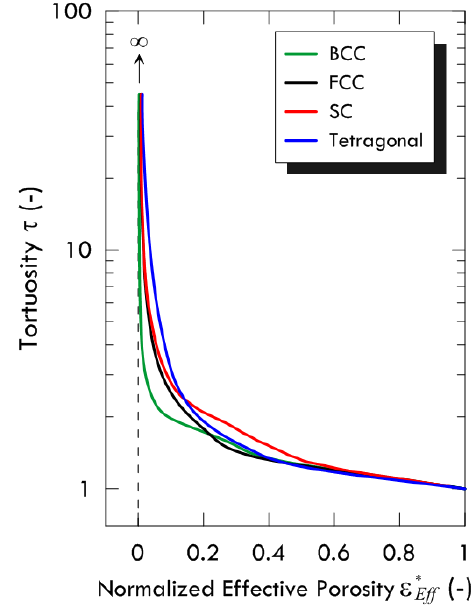
Figure 13. Tortuosity τ as a function of the Normalized Effective Porosity ε ∗ considered